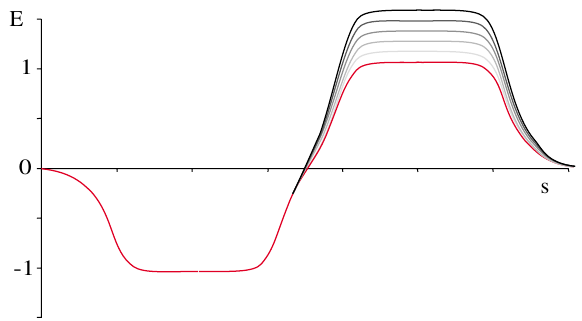
FIG. 9. (Color) Potential distribution inside the electrostatic quadrupole doublet; arbitrary